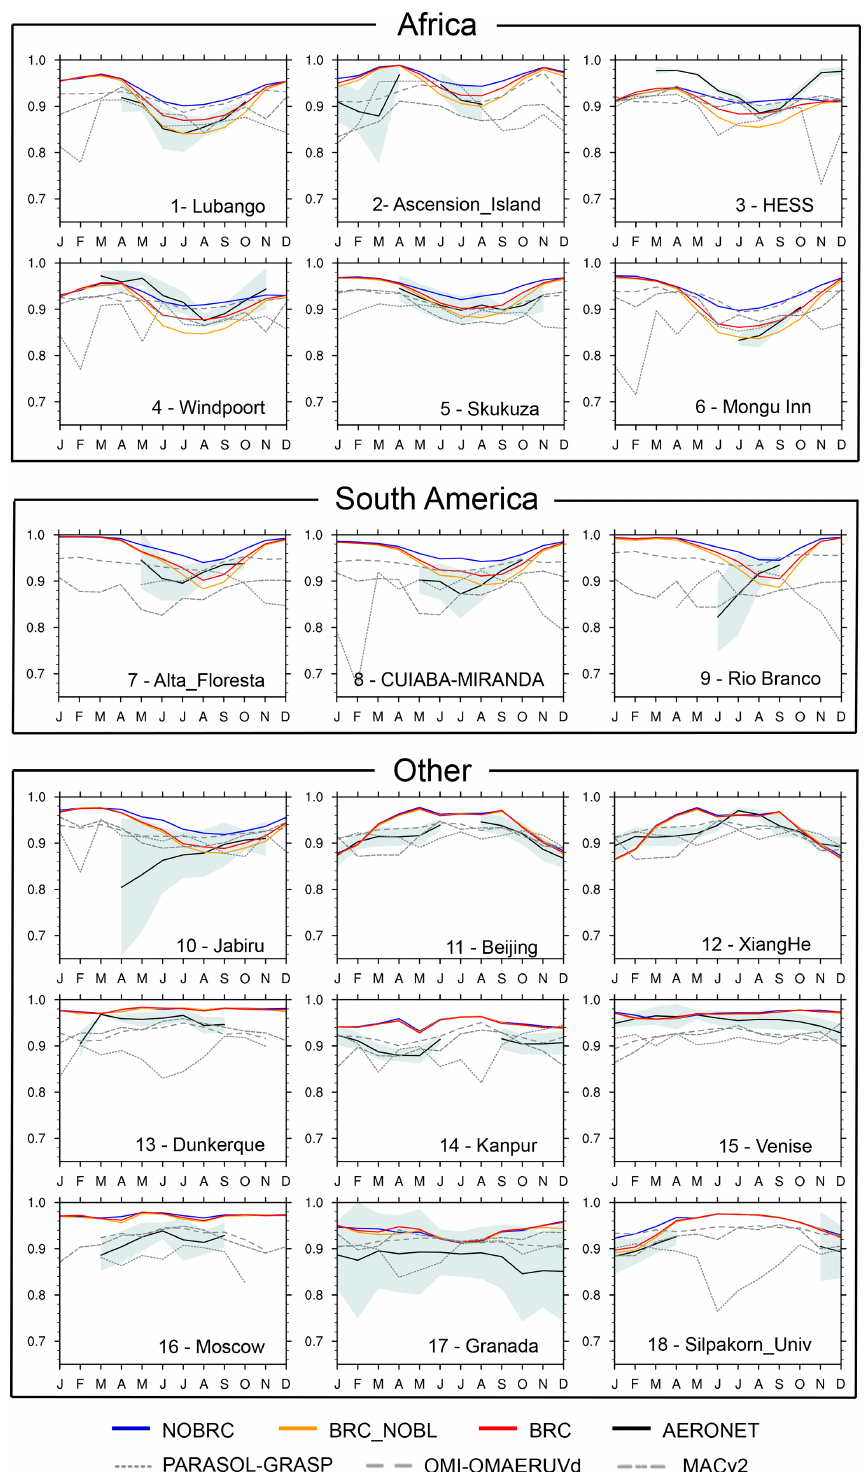
Figure 3. Annual cycle of the SSA (440nm) at AERONET stations, simulated by the ARPEGE-Climat model for the NOBRC (blue), BRC_NOBL (orange), and BRC (red) simulations (see Table 3 for details), with AERONET measurements (black, plus or minus standard deviation in light blue), and provided by the reference data sets (grey) with PARASOL-GRASP, OMI-OMAERUVd, and MACv2 (see Table 2 for details). Stations have been grouped into African ones, South American ones, and stations over the rest of the world (label “Other”). AERONET stations are detailed in Table